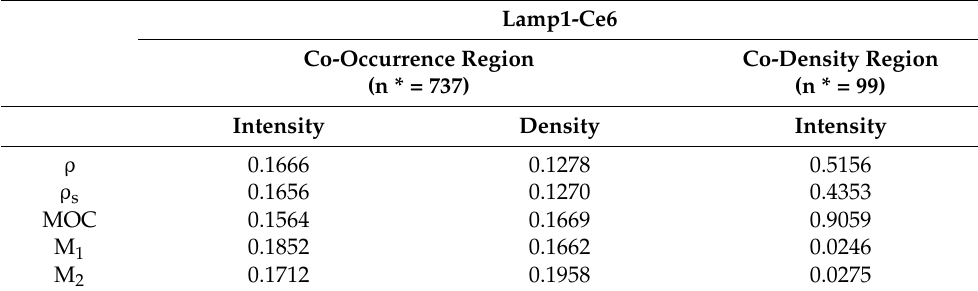
Table 2. Comparison between Lamp-1 and PTX-Ce6@ker ag intensity and local density colocalization analysis, before and after refinement for local